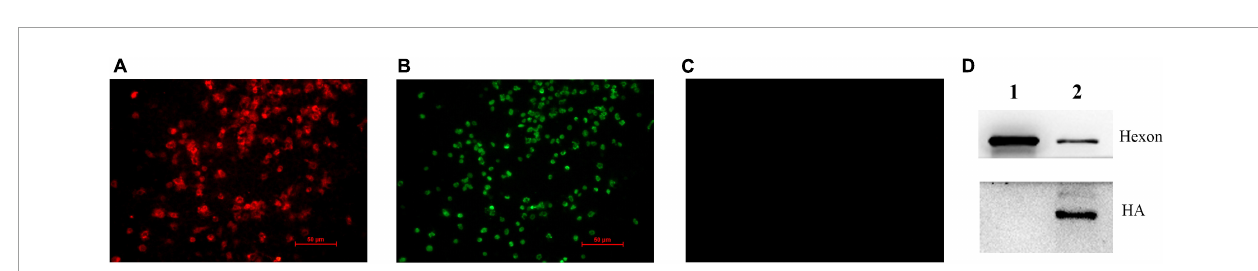
FIGURE3 Identification of the expression of HA by the recombinant virus FAdV4-HA(H9). The expression of the HA protein in LMH cells infected with FAdV4-HA(H9) were detected by IFA (A–C) and western blot (D) using mAb 2G10 against HA of H9N2 and chicken serum against FAdV-4. (A) mAb 2G10 against HA of H9N2 was used. (B) Chicken serum against FAdV-4 was used. (C) LMH cells without infection. In the western blot, lane 1 indicated the cultured supernatant of the infected LMH cells; lane 2 indicated the cell lysate of the infected LMH cells. These experiments were performed twice with comparable